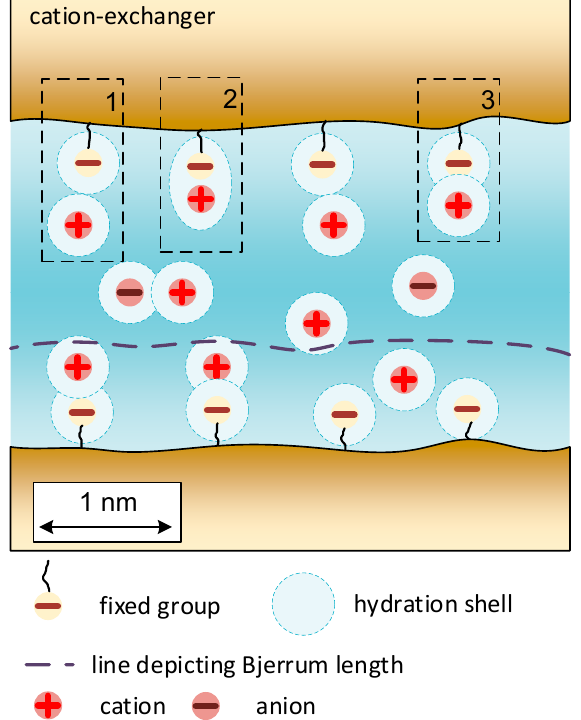
Figure 1. The schematic depiction of a micropore in a swelled membrane. The structure of ion’s pairs “fixed group-counterion” is shown: 1—ion pairs at the contact of undisturbed primary hydration shells, 2—inner-sphere complex, 3—outer-sphere complex.